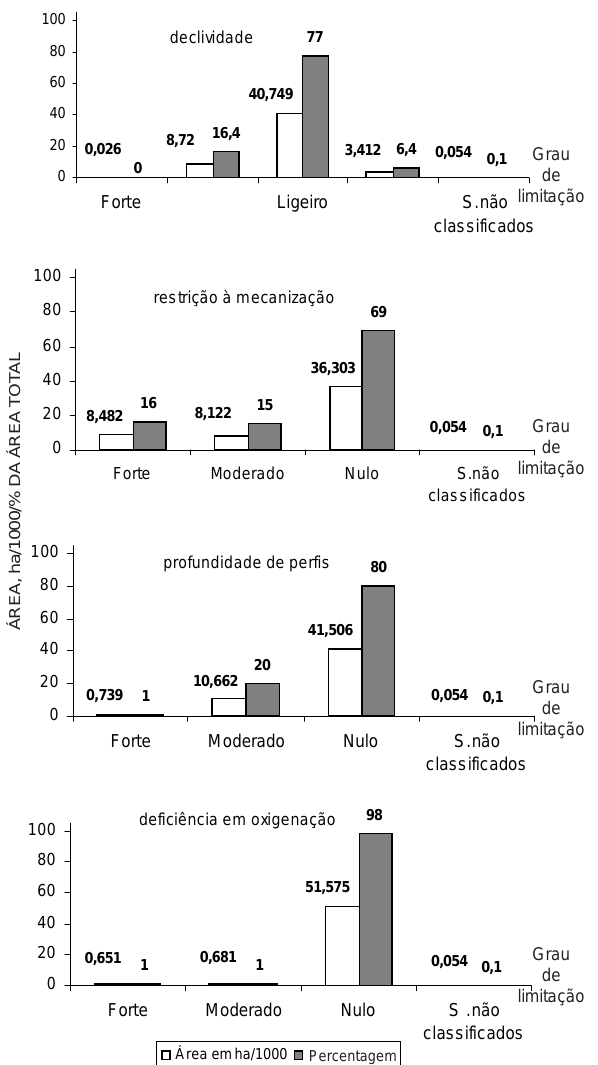
Figura 2. Distribuição das áreas, em hectares e percentagem, da Bacia do rio Jardim (DF) conforme as propriedades físicas selecionadas para a aptidão física das terras para a cultura do milho.